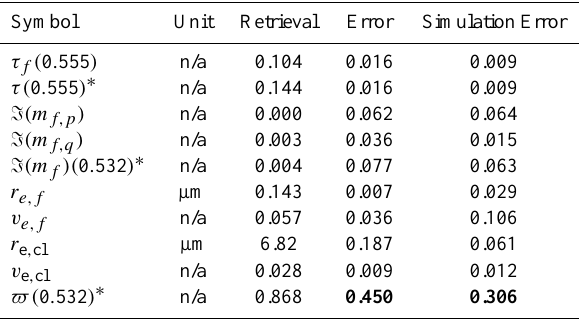
Table 3. Retrieved aerosol and cloud parameters. ∗ : These pa- rameters are derived from other parameters, not directly retrieved. Errors in bold are larger than accuracy guidelines from Mishchenko et al. (2004) (note that guidelines were not provided in this publica- tion for imaginary refractive index, and were not intended for AAC retrievals).